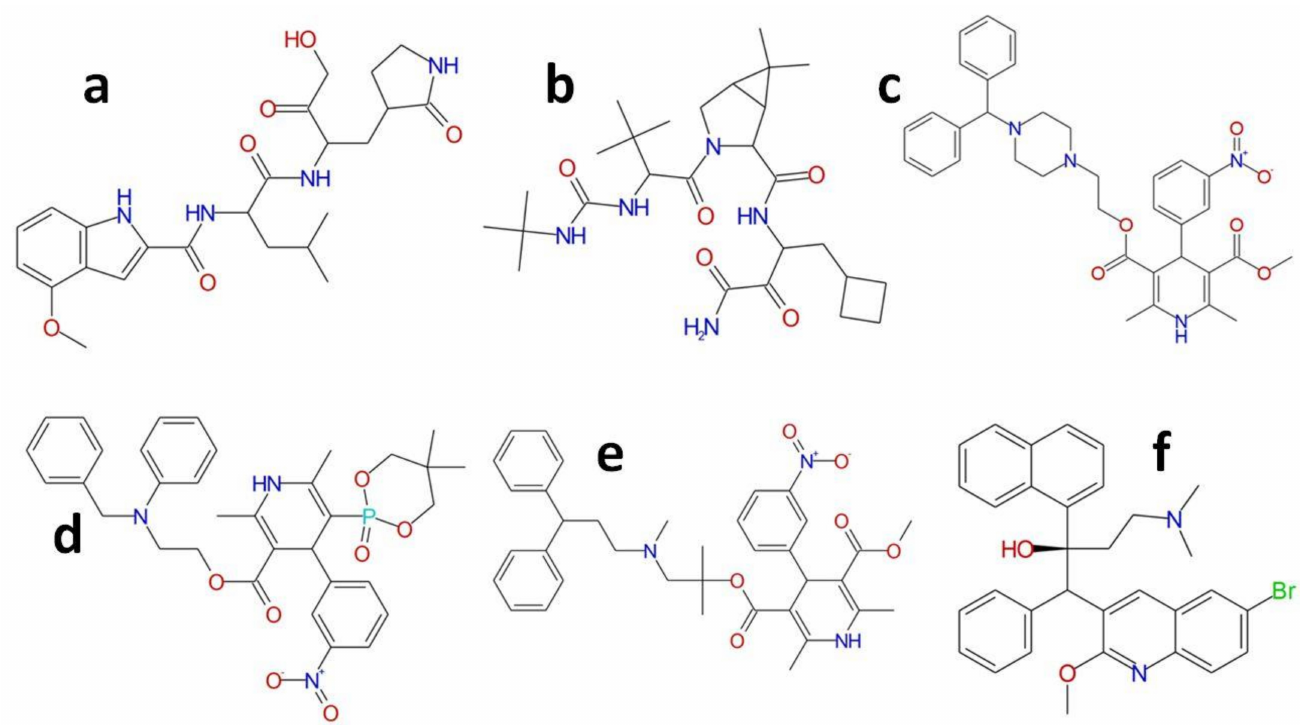
Figure 1. Structure of all of the compounds investigated in this study. ( a ) PF-00835231; ( b ) Boceprevir; ( c ) Manidipine; ( d ) Efonidipine; ( e ) Lercanidipine; ( f ) Bedaquiline.